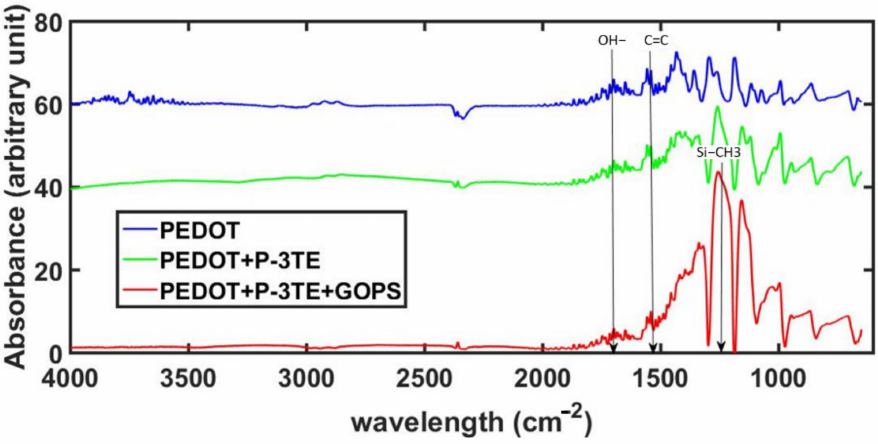
Figure 4. FTIR spectrum of PEDOT, PEDOT + P3TE and PEDOT + P3TE + GOPS measured on a silicon wafer.